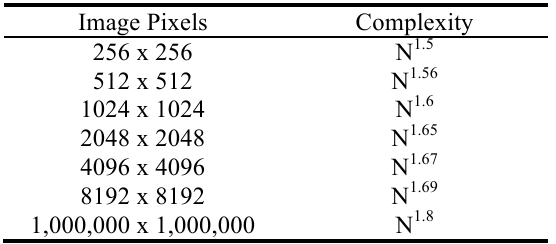
Table 1. Computational complexity at various